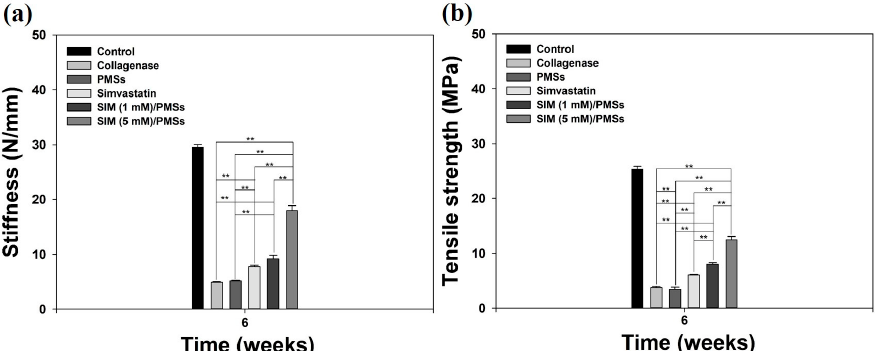
Figure 5. ( a ) Stiffness and ( b ) tensile strengths of Achilles tendon tissues isolated from collagenase-induced Achilles tendinitis rat models in each group at 6 weeks after treatments with PMSs, simvastatin, SIM (1 mM)/PMSs, and SIM (5 mM)/PMSs. Data represent means ± SDs ( n = 4). (** p < 0.01).